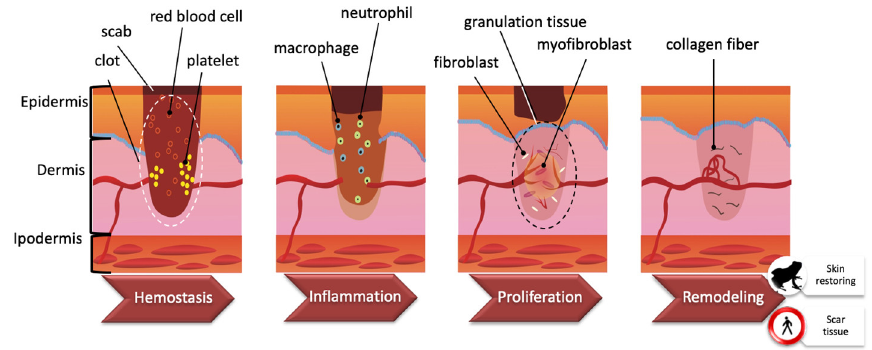
Figure 3. Wound healing process. Wound healing is a complex process encompassing a number of overlapping phases, including hemostasis, inflammation, proliferation, and remodeling. See the text for further explanation (Modified from [15]).